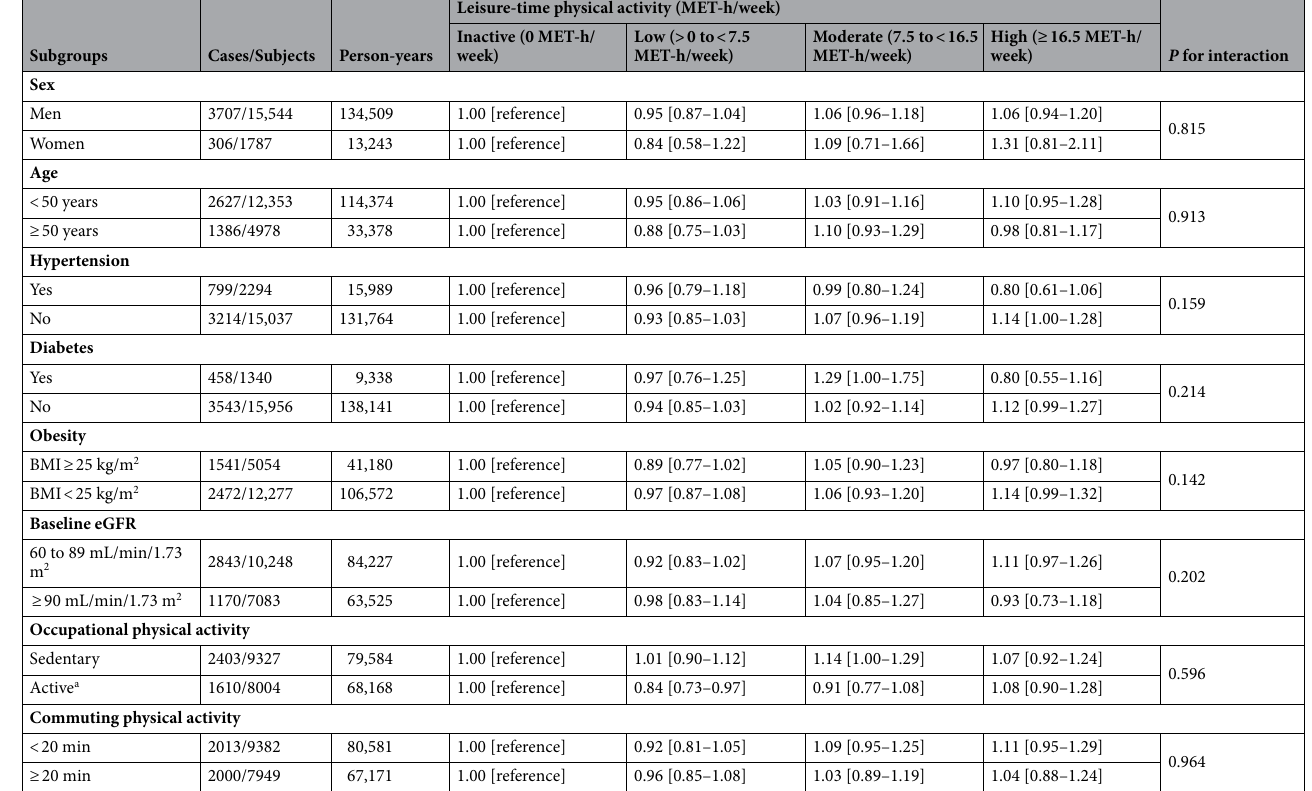
Table 3. Hazard ratios of chronic kidney disease according to the volume of leisure-time physical activity in subgroups. Data are shown as the hazard ratio [95% confidence interval]. BMI body mass index. a Active including standing, walking, and fairly active at work. The Cox proportional hazards regression adjusted for baseline age (continuous), sex, smoking status (never, former, or current), alcohol consumption (0, > 0 to < 2, or ≥ 2go/day), occupation (engineering, production, office and administration, or others), job position (high or low), overtime work (< 45, 45 to < 60, 60 to < 80, 80 to < 100, or ≥ 100 h), shift work (yes or no), primary commuting mode (walking, bicycling, train/bus, or car/motorbike), sleep duration (< 5, 5 to < 6, 6 to < 7, or ≥ 7 h per day), hypertension, diabetes, history of cardiovascular disease, dyslipidemia, hyperuricemia, body mass index (< 18.5, 18.5 to < 25.0, 25.0 to < 30.0, or ≥ 30.0 kg/m 2 ), baseline estimated glomerular filtration rate (60–89 or ≥ 90 mL/min/1.73 m 2 ), occupational physical activity (sedentary, standing or walking, and fairly physically activity), and walking for commuting to and from work (< 20 min, 20 to < 40 min, or ≥ 40